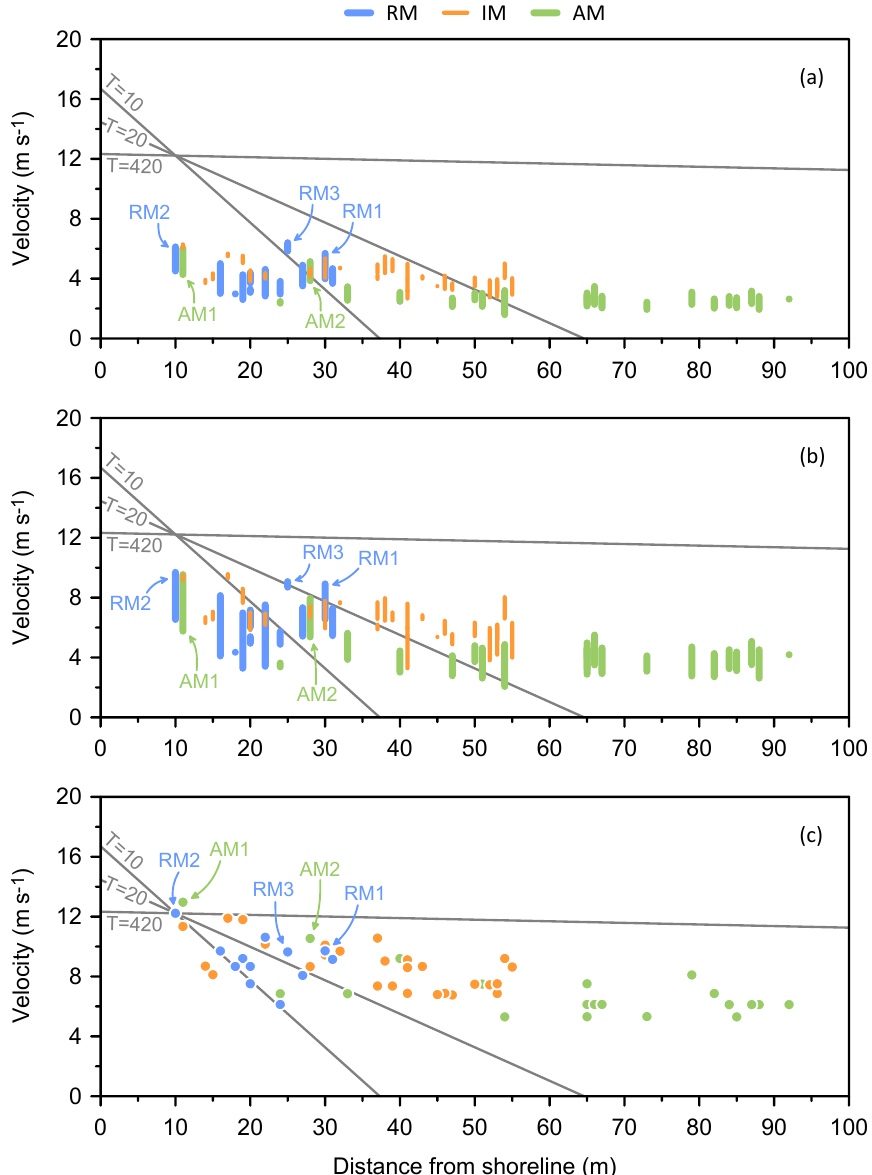
Figure 17. Wave velocity decay profiles for two hypothetical storm waves and one hypothetical tsunami (Equation (6)), denoted by their wave period, T (s). The profiles are compared against the minimum velocities (after [19]) required to emplace boulders at their inland positions by: ( a ) sliding (Equations (1a) and (1b)); ( b ) rolling (Equations (2a) and (2b)), and; ( c ) lifting / saltating (Equation (3)). The boulders of interest are classified as recent movers (RM), indeterminate movers (IM) and ancient movers (AM), with prominent labelled boulders discussed in the text. For sliding and rolling, vertical lines di ff erentiate between flow-normal orientation of boulders (bottom of line) and flow-parallel orientation (top of line). The lifting of recent mover RM2 to deposit atop the Globigerina scarp is used as the calibration movement for setting the magnitude of the decay